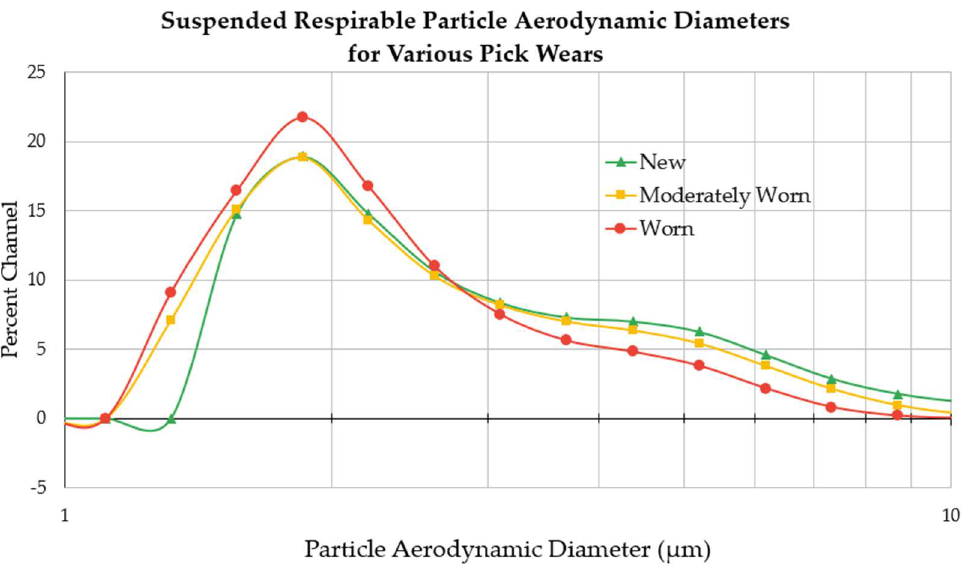
Figure 10. The particle size distribution of the suspended respirable particles generated from the new, moderately worn, and fully worn pick determined from laser diffraction of particles collected onto PC filters with cyclones.